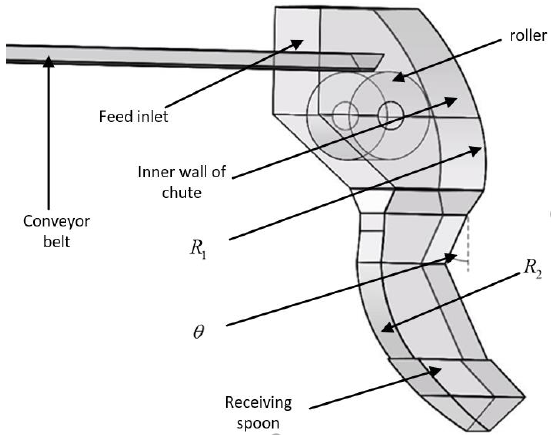
Figure 1. Structure of the chute.